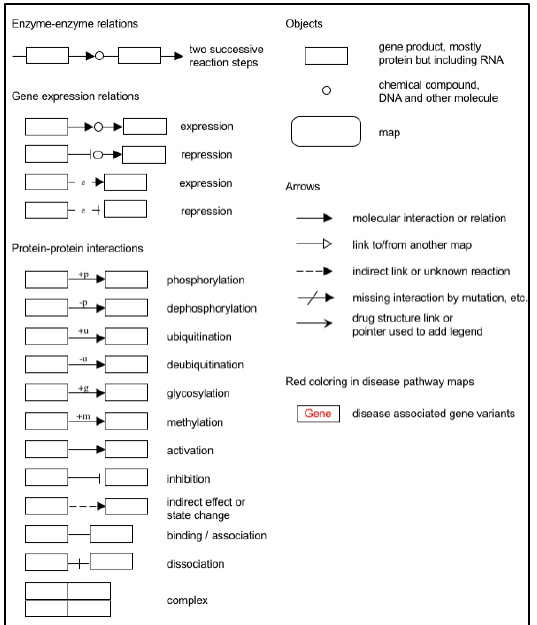
Figure 8. Expanded Kyoto Encyclopedia of Genes and Genomes (KEGG) pathway representation of colorectal carcinoma showing the involvement of the 16 candidate biomarkers selected for this study in the pathogenesis of CRC. The cancer pathways that these 16 CBs are involved in include ( A ) ERK signaling; ( B ) PI3K signaling; ( C ) RAS signaling; ( D ) WNT signaling; ( E ) TGFB signaling; ( F ) Apoptotic signaling; ( G ) Transcription. Genes marked with yellow rectangles represent the 16 CBs identified in this scoping review.